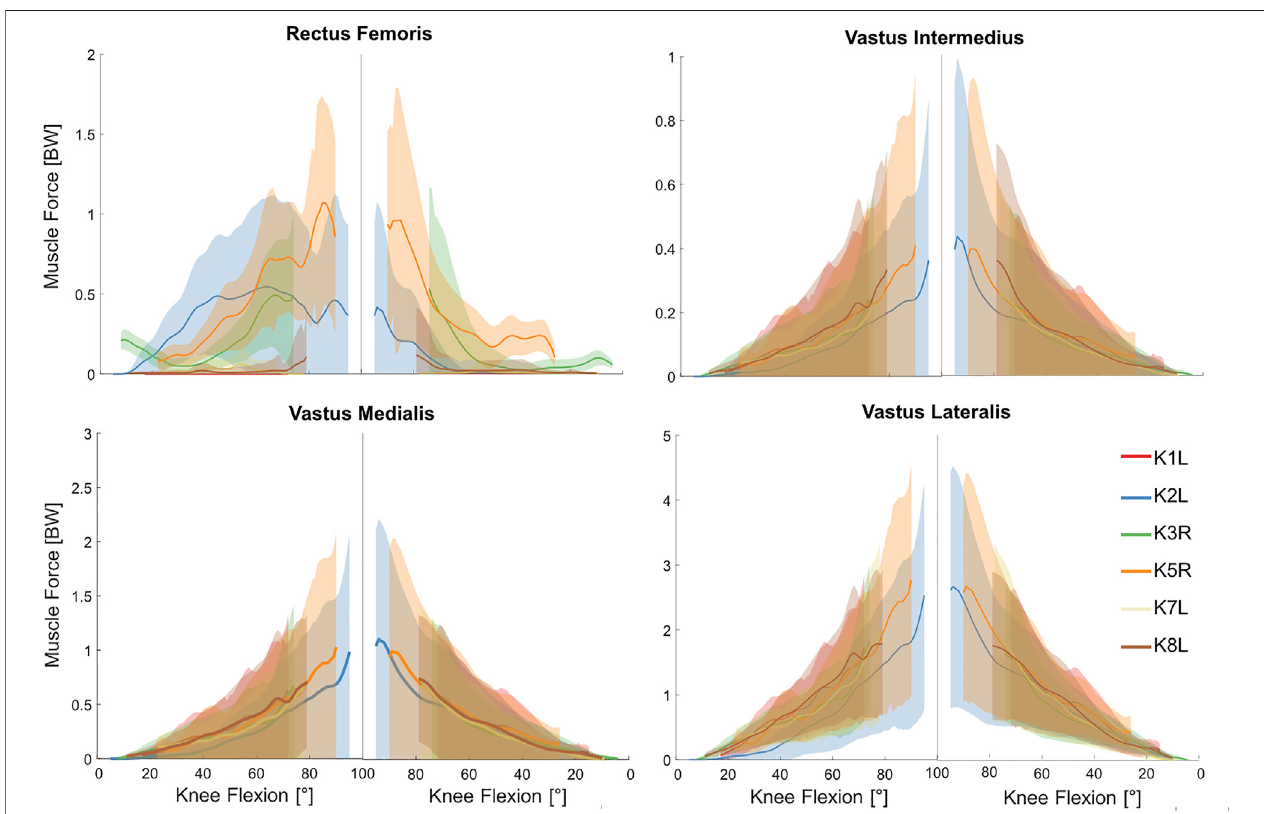
FIGURE 3 | Estimated forces in the knee extensor muscles obtained from the baseline musculoskeletal models (solid lines) and 5th – 95th percentile range of the general Monte Carlo simulation outputs (shaded area) for the studied squat trials.